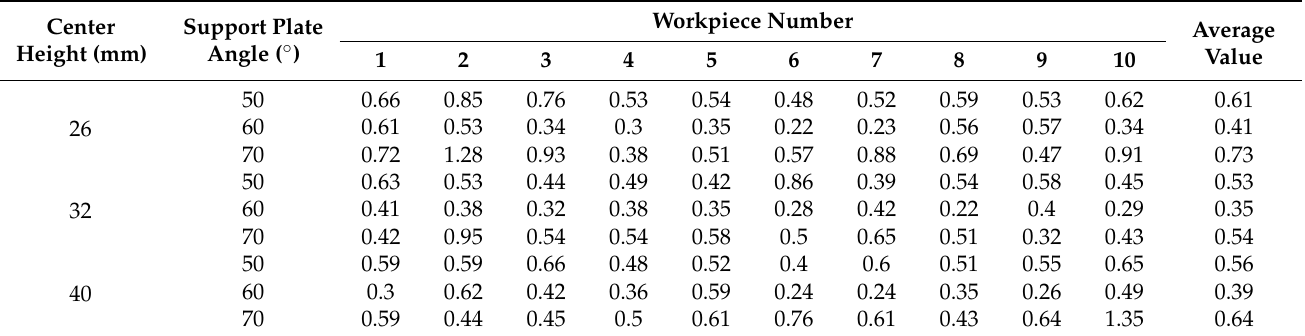
Table 3. Roundness error value obtained under conditions of different center heights and support plate angles.